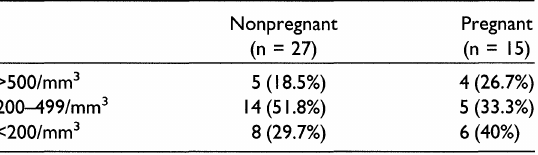
TABLE 2. Mantoux skin test results TABLE 3. CD4+T-lymphocyte counts in patients with anergic skin test